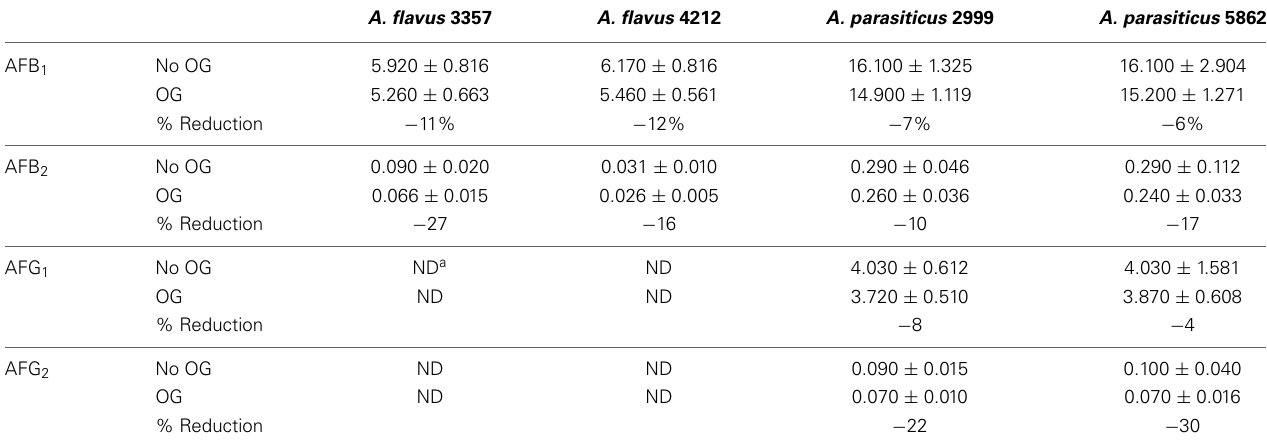
Table 5 | Antiaflatoxigenic activity of OG in A. flavus 3357, 4212, A. parasiticus 2999 (OG at 25 µ M) and A. parasiticus 5862 (OG at 50 µ